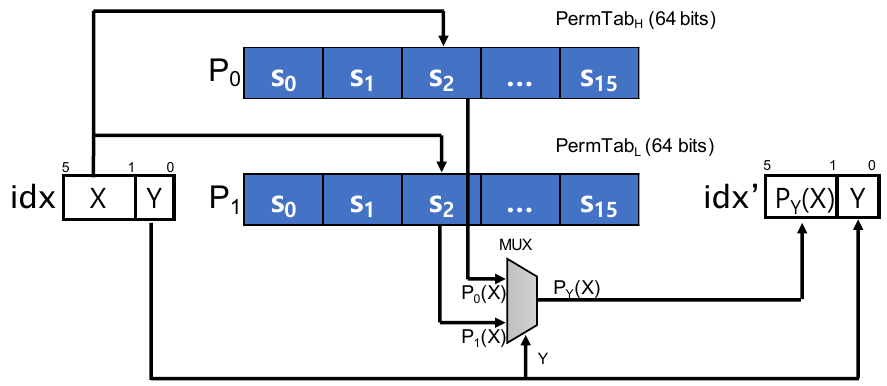
Figure 2. The process of constant-time